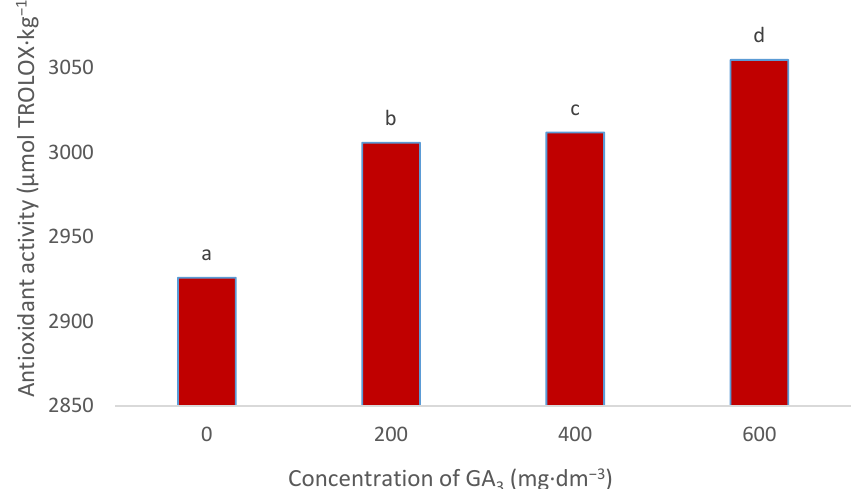
Figure 5. Antioxidant activity of the extracts from tubers of the Crocosmia × crocosmiiflora ‘Lucifer’ after application of GA 3 . Means followed by the same letter do not differ significantly at α = 0.05.